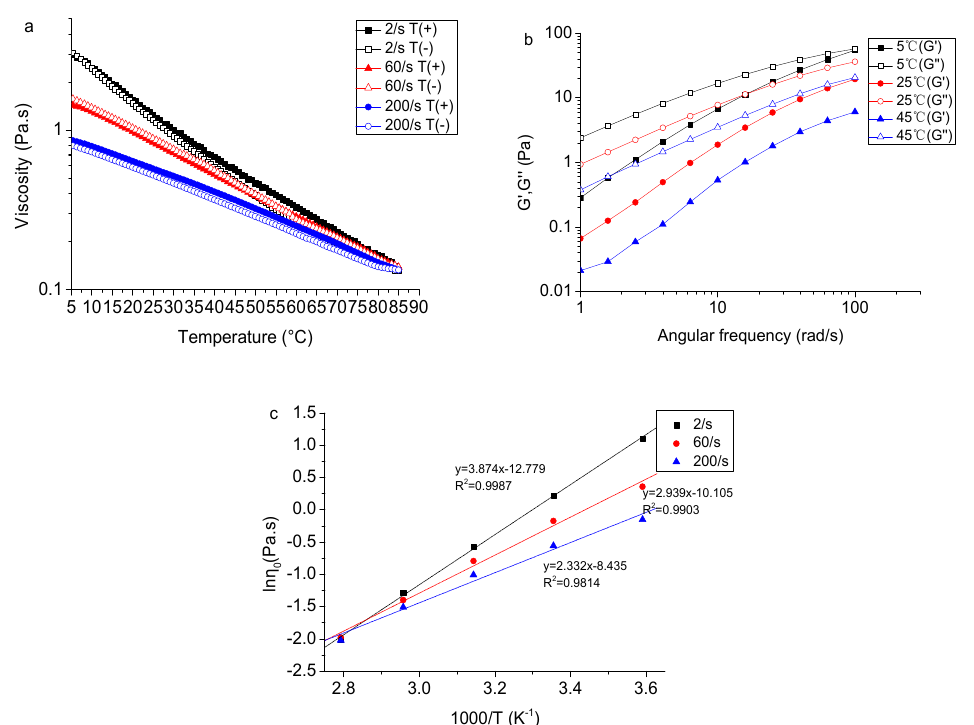
Figure 6. ( a ) Effects of temperature on the apparent viscosity of TSP (2%, w / v ) at different shear rates; ( b ) Effects of temperature on dynamic modulus of TSP (2%, w / v ) at 2 s − 1 ; ( c ) Arrhenius plots for apparent viscosities of TSP solution (2%, w / v ) at different shear rates.